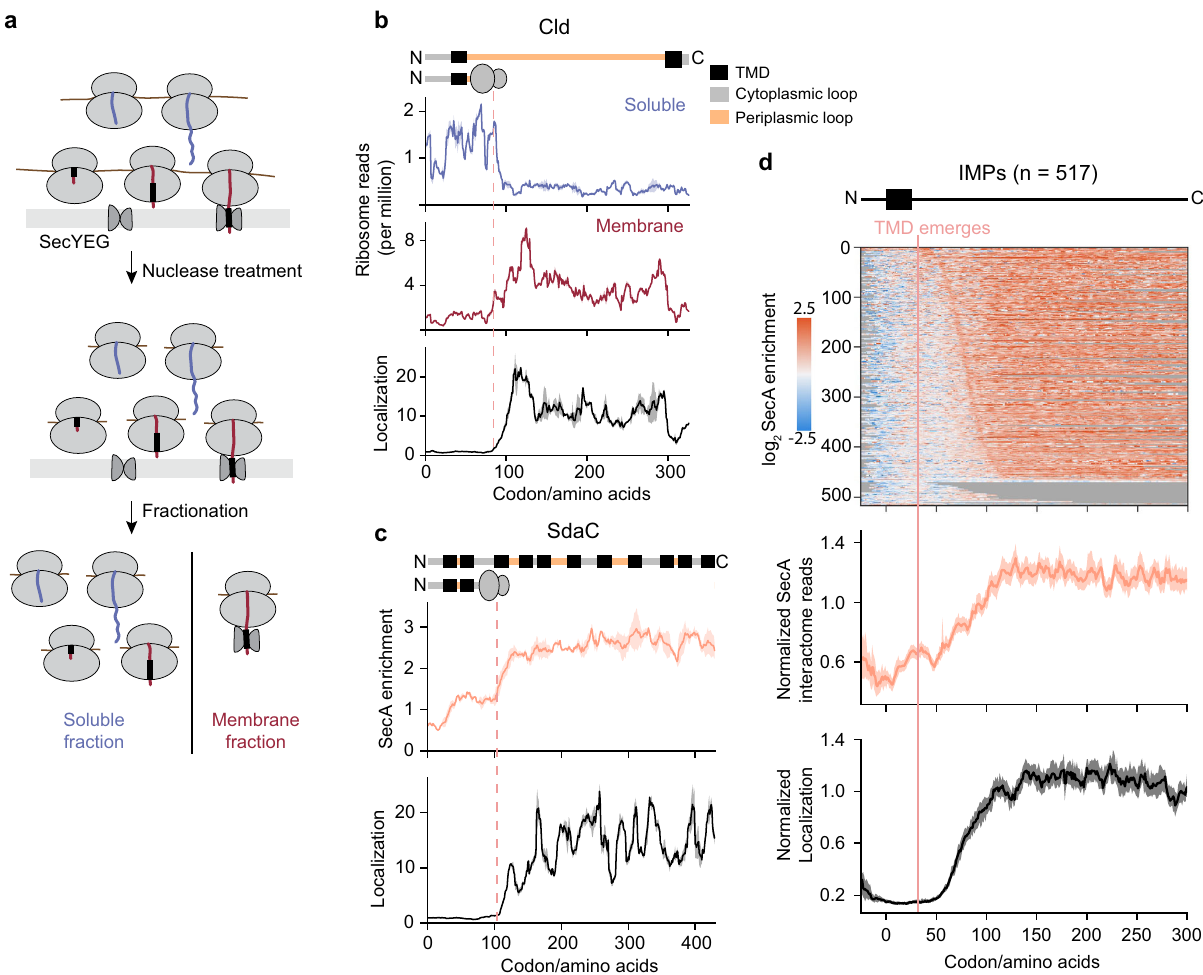
Fig. 2 Fractionation-coupled ribosome pro fi ling reveals the timing of cotranslational membrane targeting. a Schematic of fractionation-coupled ribosome pro fi ling. b Representative ribosome localization pro fi le of an IMP. The localization score at each codon was calculated as the ratio of ribosome- protected reads in the membrane faction relative to those in the soluble fraction. Protein topology is shown above, with TMD in black, cytoplasmic loops in grey, and periplasmic loops in yellow. c Representative SecA interaction pro fi le and ribosome localization pro fi le of an IMP. Protein topology is shown above and colored as in b . d Metagene SecA interactome pro fi le and ribosome localization pro fi le of IMPs aligned to the N-terminus of the fi rst TMD. The heatmap above shows the log 2 SecA enrichment at each codon of all the IMPs used to derive the metagene SecA interactome pro fi le, sorted by increasing distance from the TMD to the onset of SecA binding. In b and c , solid lines show the mean values, and shaded areas show the range of data from two independent biological replicates. In d , solid lines show the mean values, and shaded areas show the 95% con fi dence interval